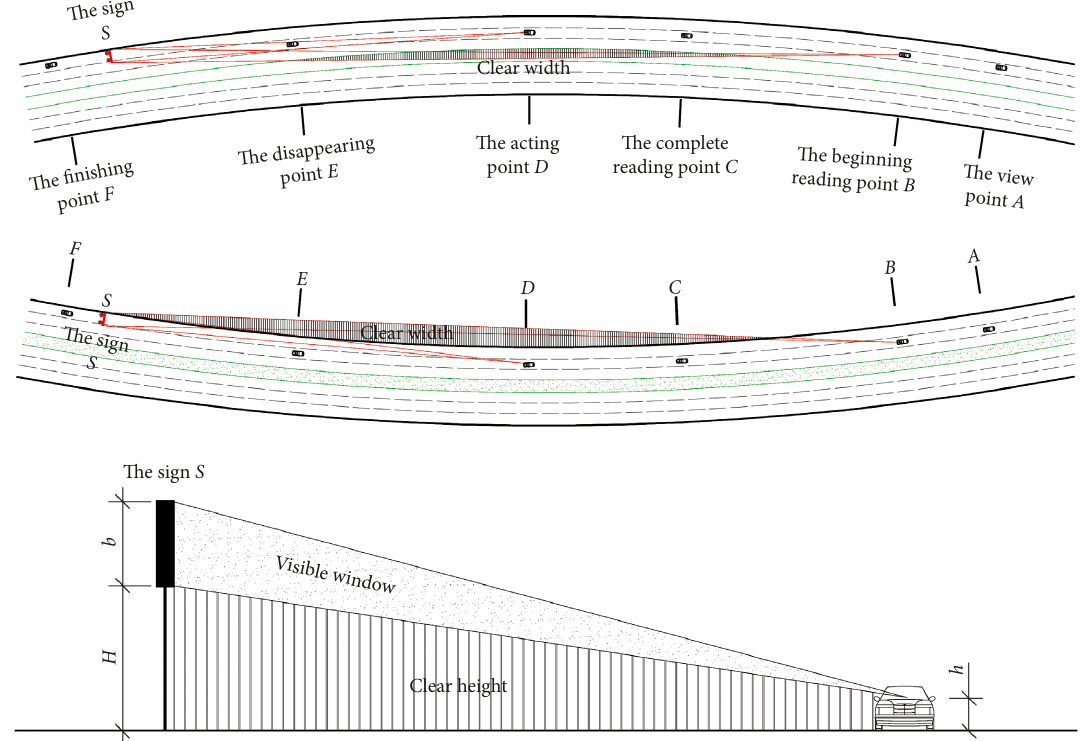
Figure 10: Schematic diagram of sign clearance